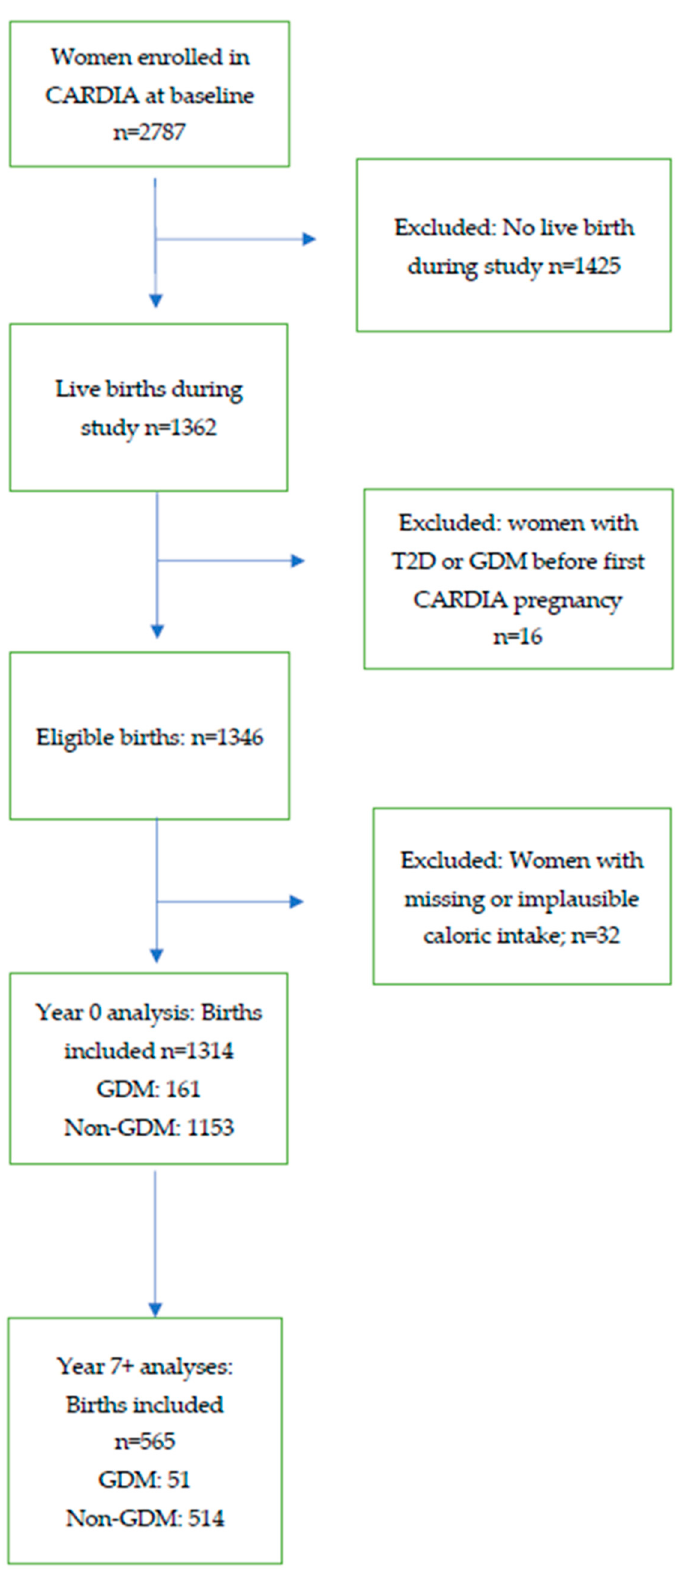
Figure 1. Flow diagram of analytic sample selection, the Coronary Artery Risk Development in Young Adults (CARDIA) Study, 1985–2011.